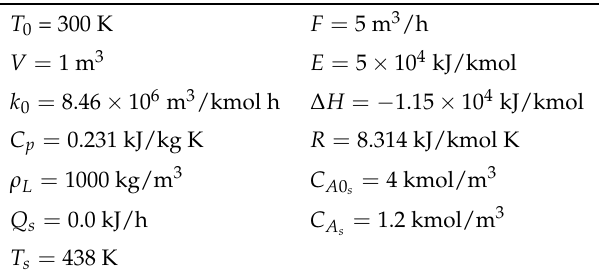
Table 1. Parameter values of the